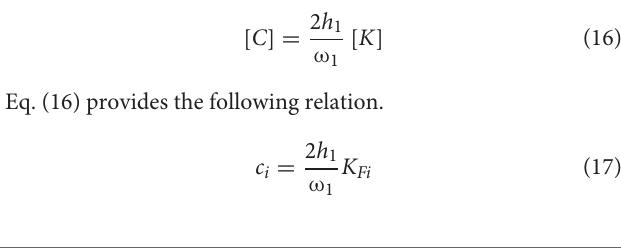
case of d gh = d y and d Ly = 2 d y is treated. Figure 5 indicates